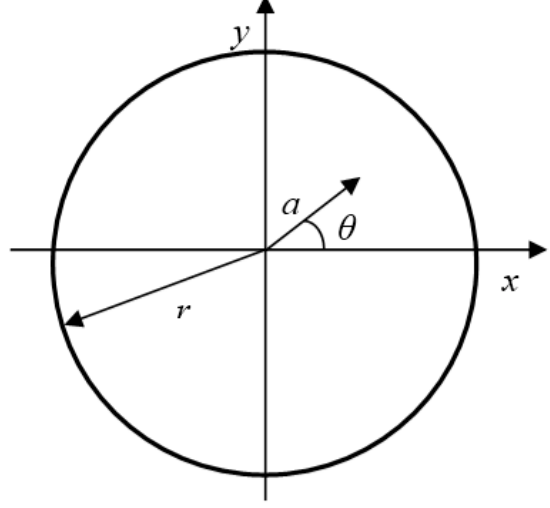
Figure 5. Schematic diagram of the cross section of the wire.